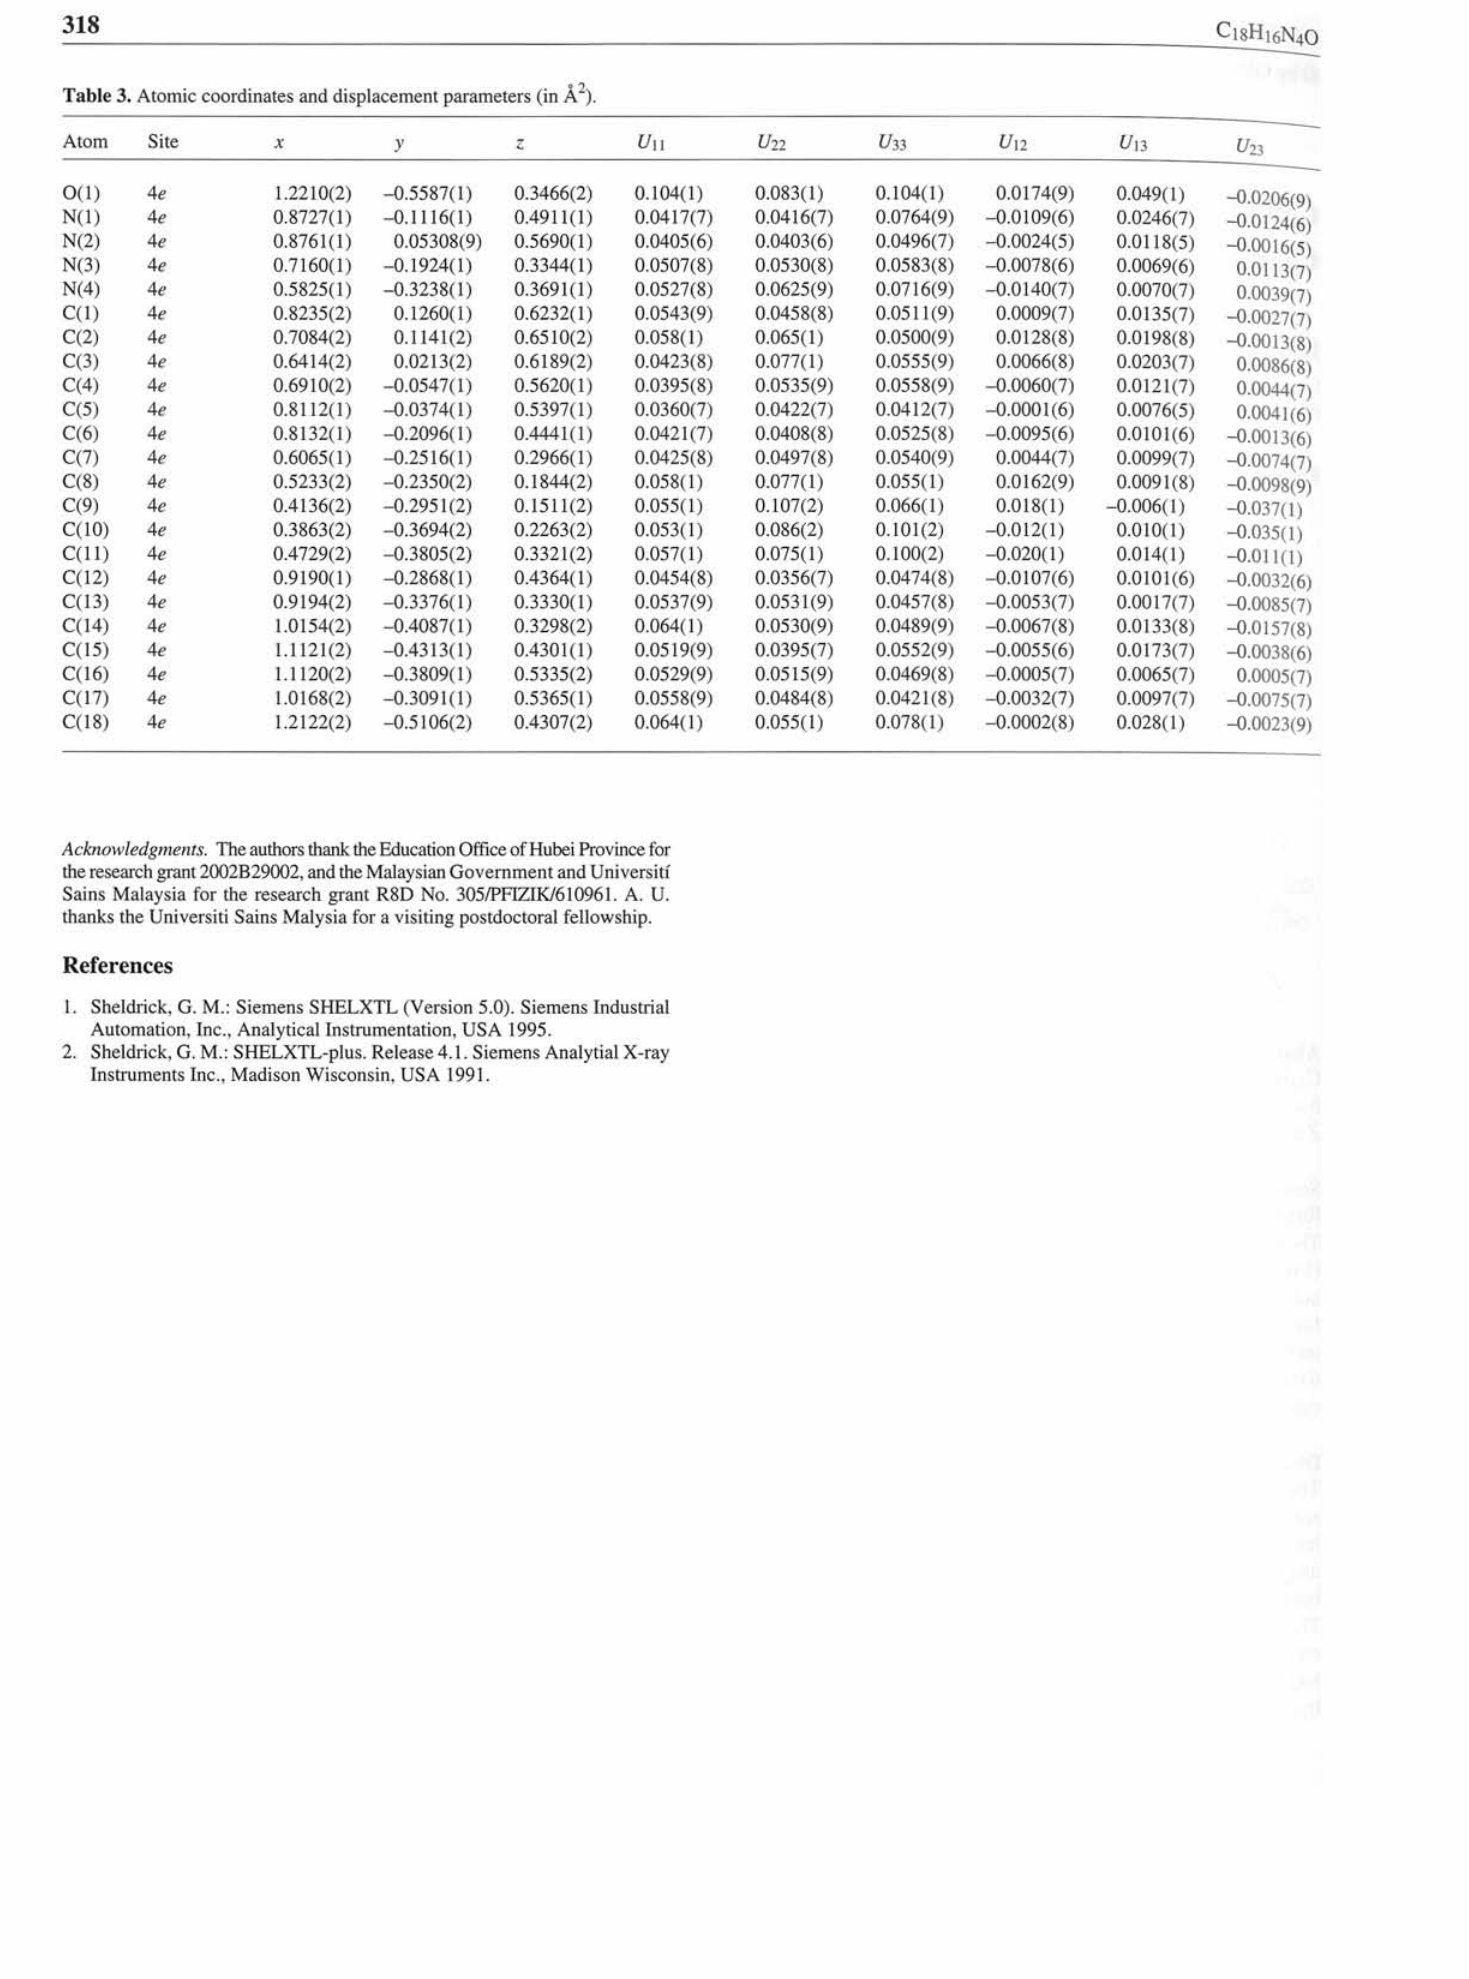
Table 3. Atomic coordinates and displacement parameters (in